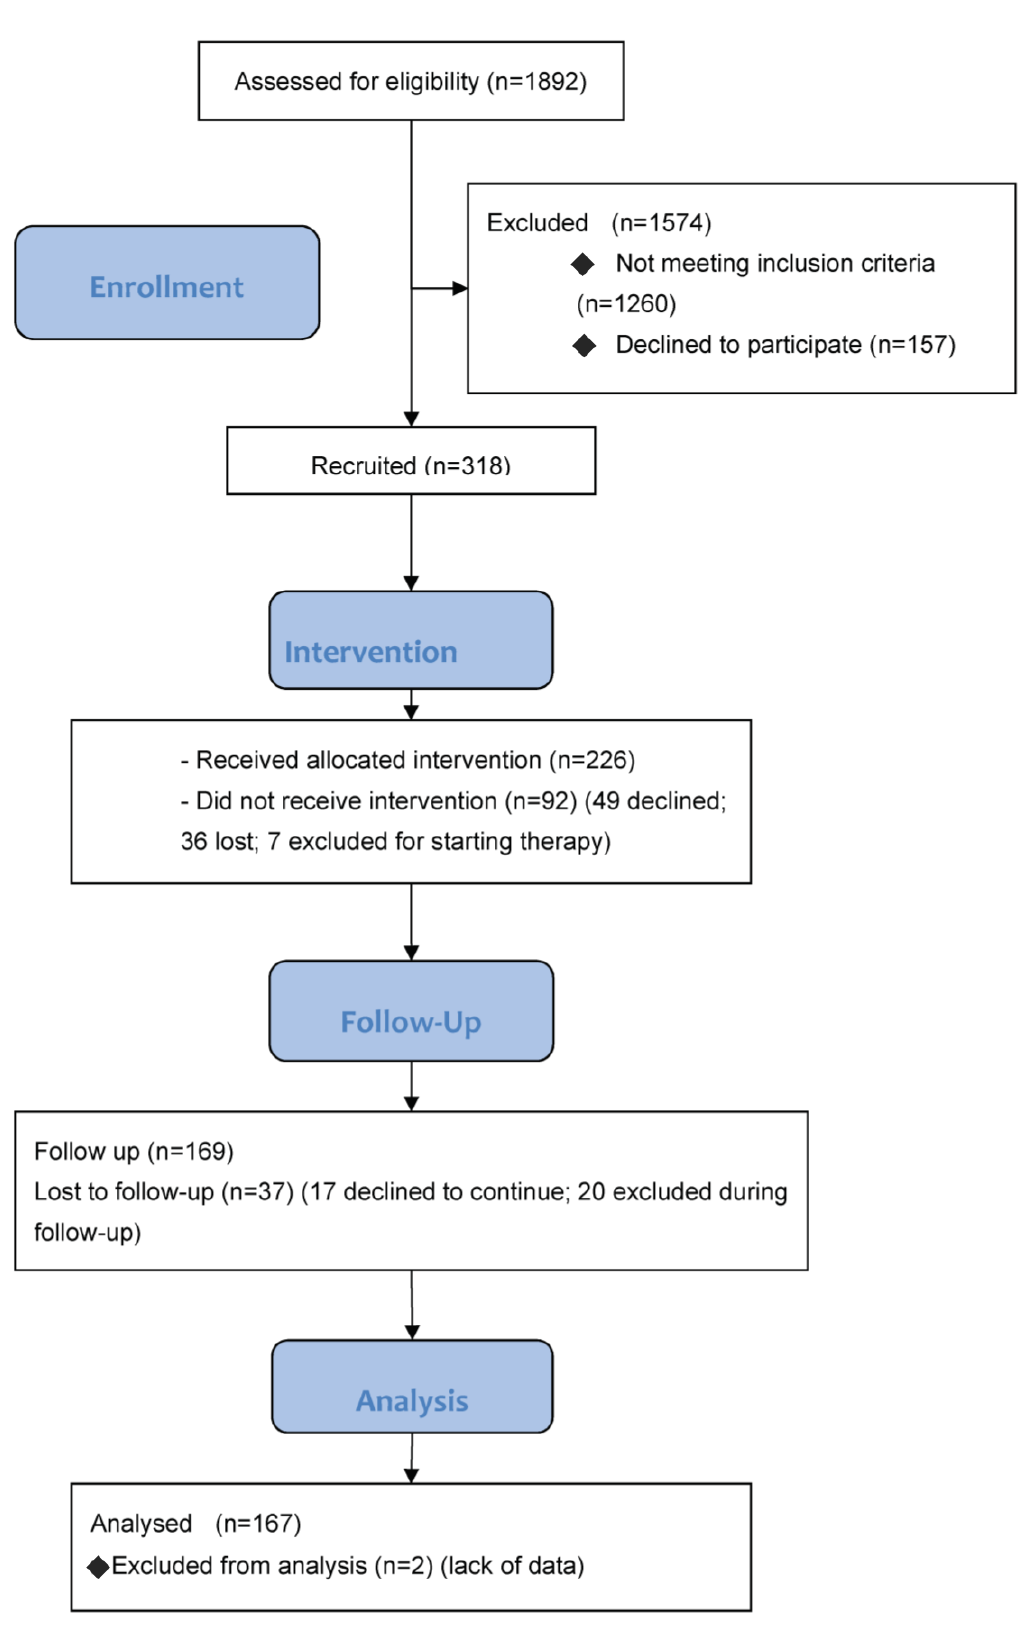
Figure 1. Flow chart and sample size.